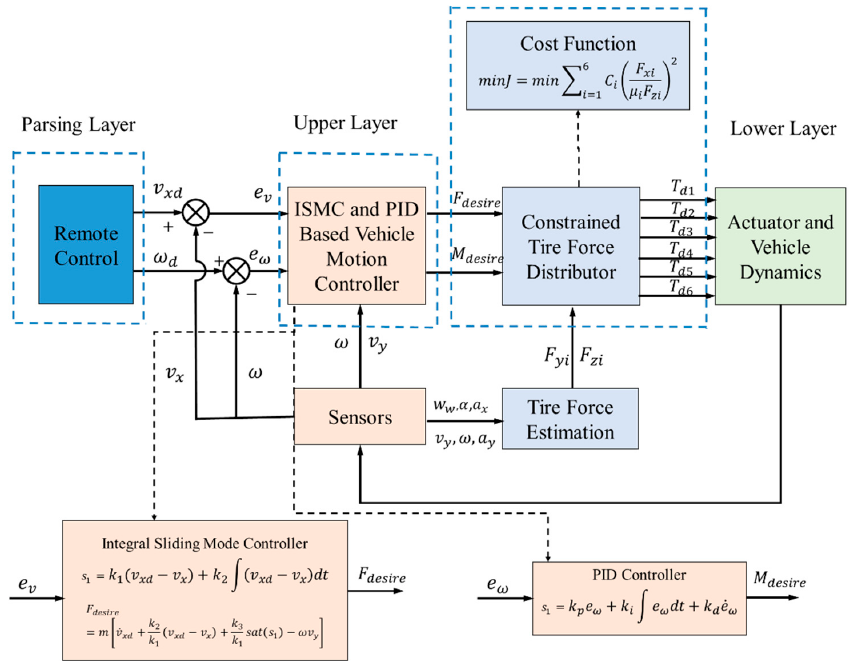
Figure 5. Schematic diagram of the controller.